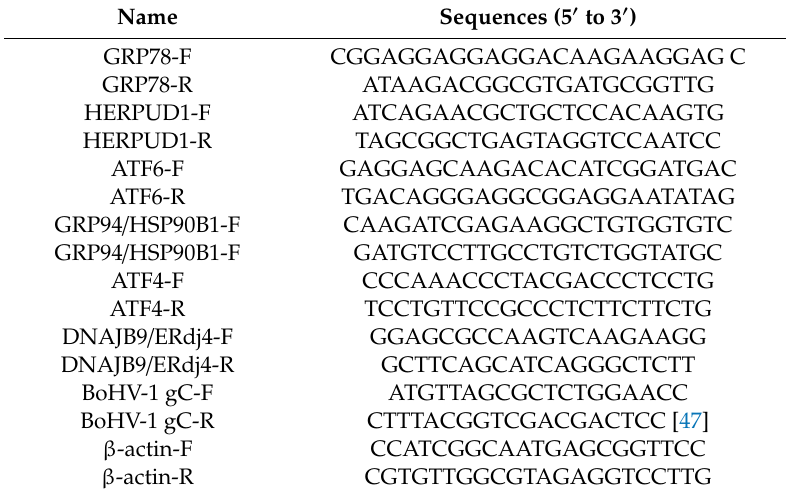
Table 2. The primers used for quantitative-PCR (qPCR)